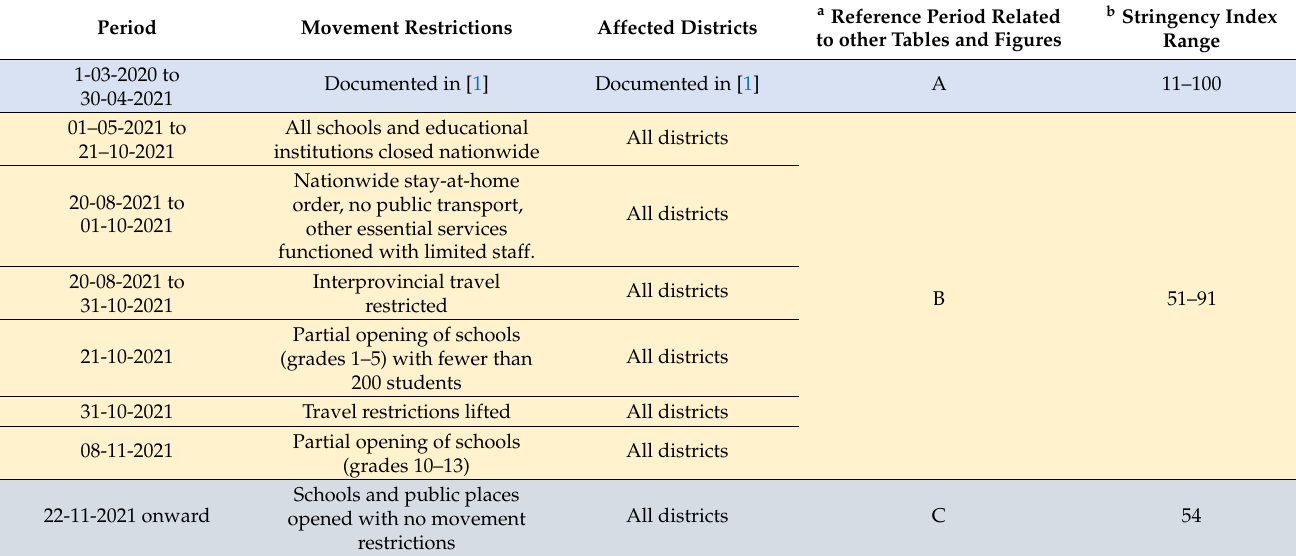
Table 1. Timeline of population movement restrictions with the aim of suppressing COVID-19